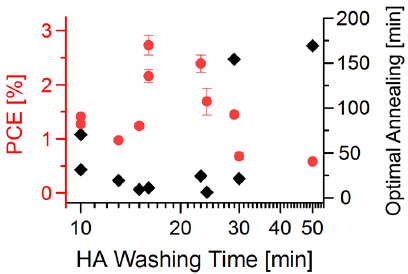
Figure 6. Power conversion efficiencies (PCEs) (red spherical points) obtained from 36 hybrid BHJ solar cells containing CdSe QDs (100:2:2) washed for different times in HA, and the optimal annealing time (black rhombic points) required to reach this efficiency.